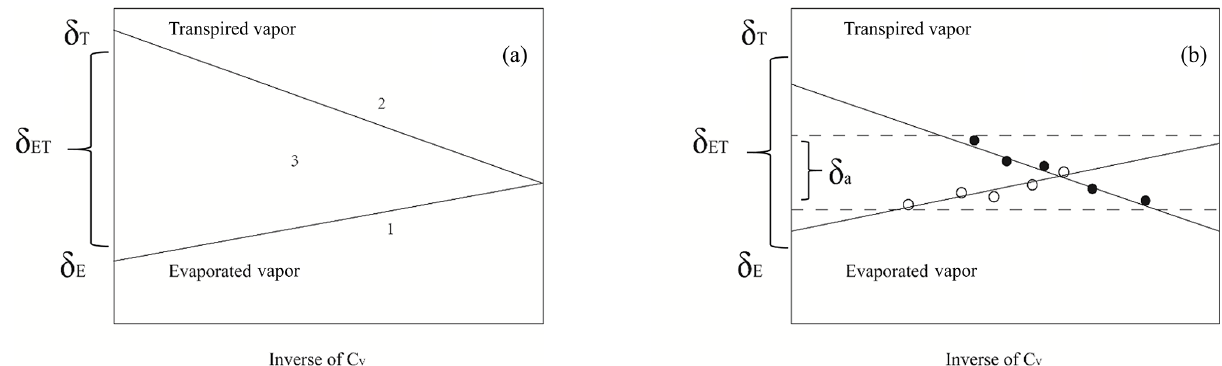
Figure 5. Hypothetical graph of the idealized Keeling plots of the isotope composition of evaporation vapor ( δ E ) (line 1), the isotope composition of transpiration vapor ( δ T ) (line 2) and the isotope composition of evapotranspiration vapor ( δ ET ) (area 3) (a) . Hypothetical graph of idealized δ E and δ T lines and the interval of the possible isotope composition of ambient vapor ( δ a ) in the Keeling plots (b) .